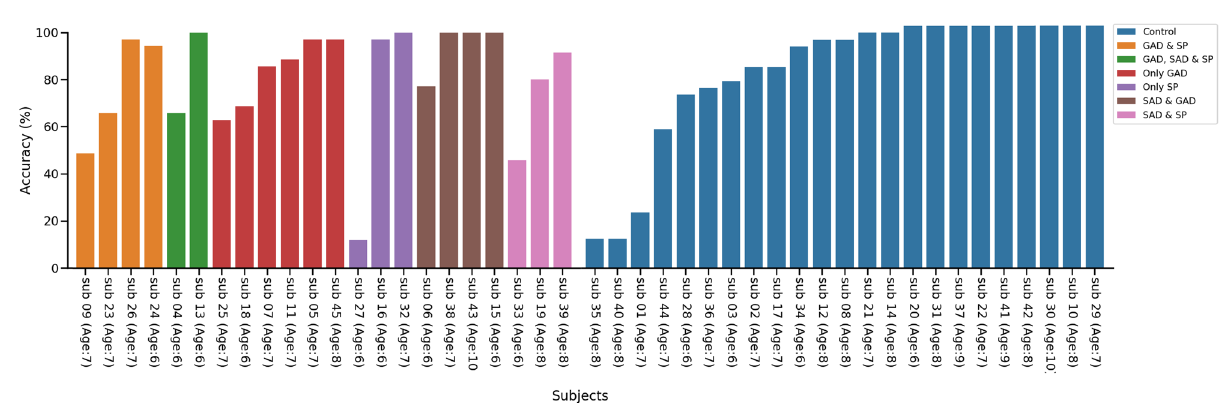
Figure 3. Individual accuracies (%) of participants based on sub-classes from final super learner model. A plot of each participants mean accuracy across 35 time points, grouped by subtypes from our final AdaBoost model, which learned from voxels in only region #